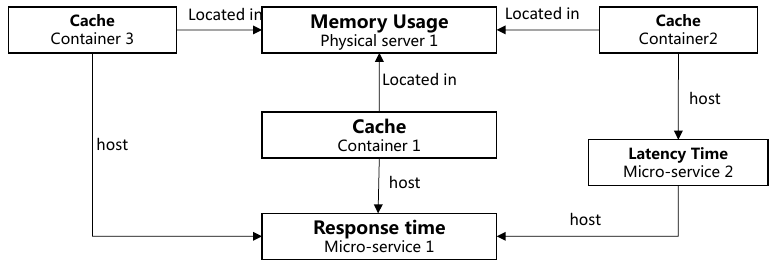
Figure 3. Sample knowledge graph for KPIs from monitoring